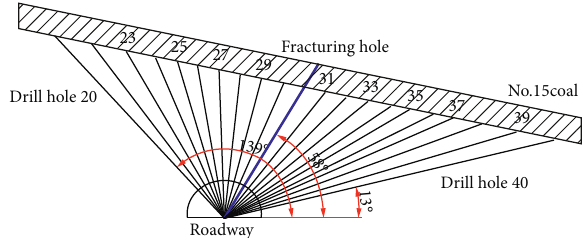
Figure 7: Sectional view of the observation hole number of the pressure holding hole.